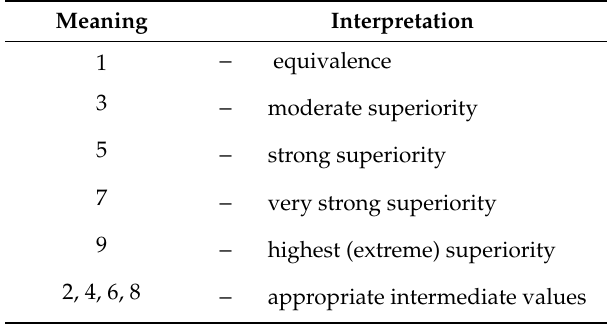
Table 3. Scale of evaluation of hierarchies by